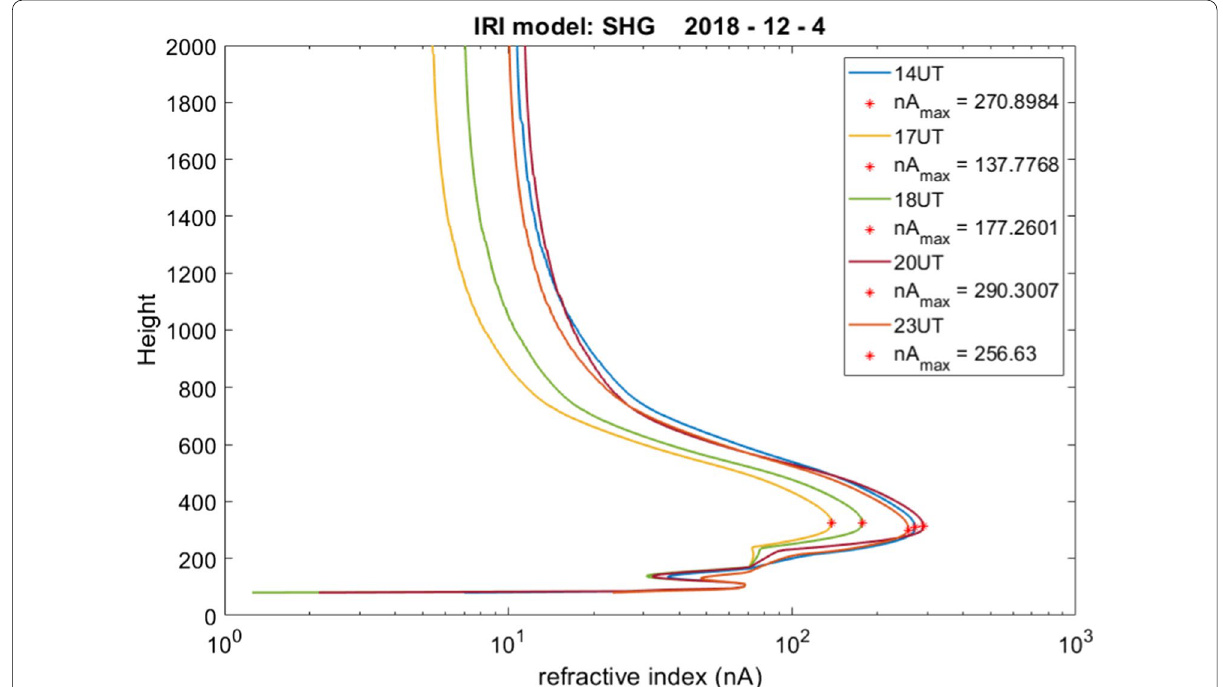
Fig. 7 Altitudinal profile of refractive index obtained by using IRI 2016 model for various UT on December 04,